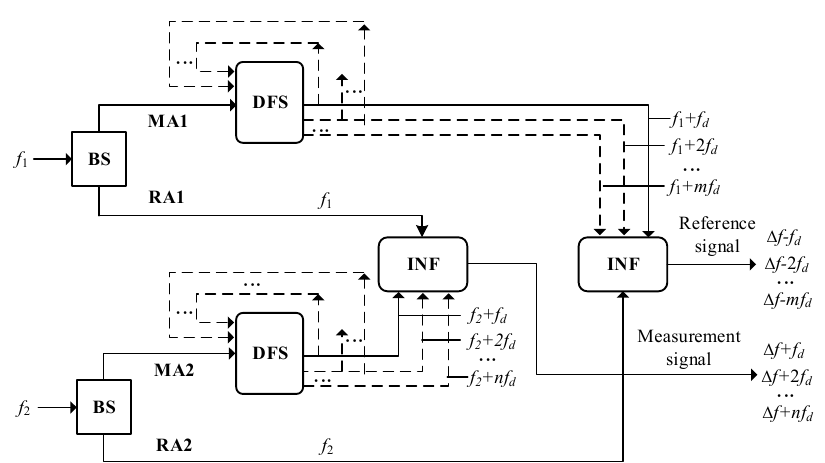
Figure 1. Schematic of formation mechanism of the reference and measurement signals in heterodyne laser interferometers with spatially separated optical paths and bidirectional DFS. BS: beam splitter, MA: measurement arm, RA: reference arm, DFS: Doppler frequency shift, INF: interference.